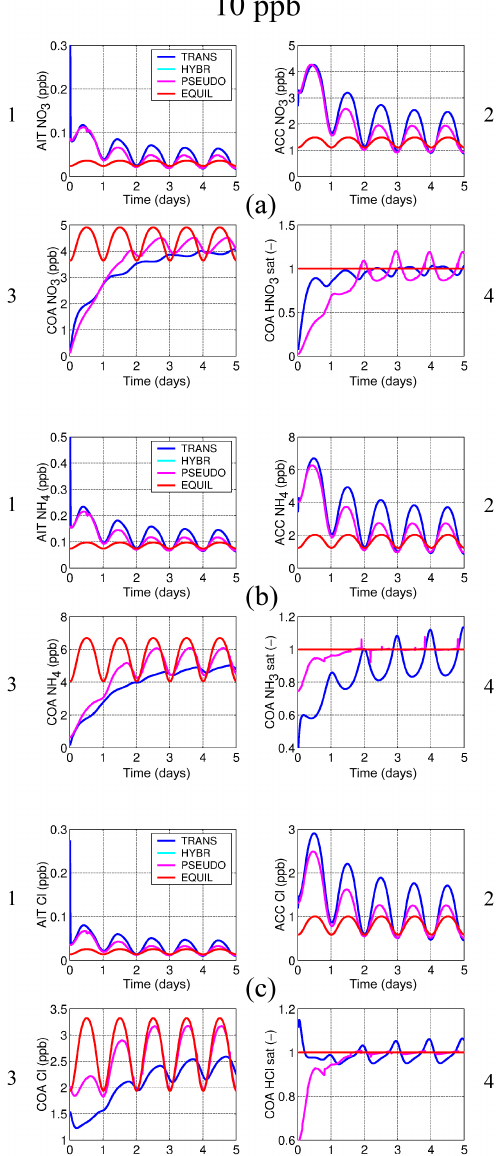
Figure 11. Same as Fig. 9 with initial mixing ratios of HNO 3 (g), NH 3 (g), and HCl(g) of 100ppb, and the gas phase (1) shown instead of the Aitken mode, respectively. Note that due to sea salt, total chloride is slightly larger than